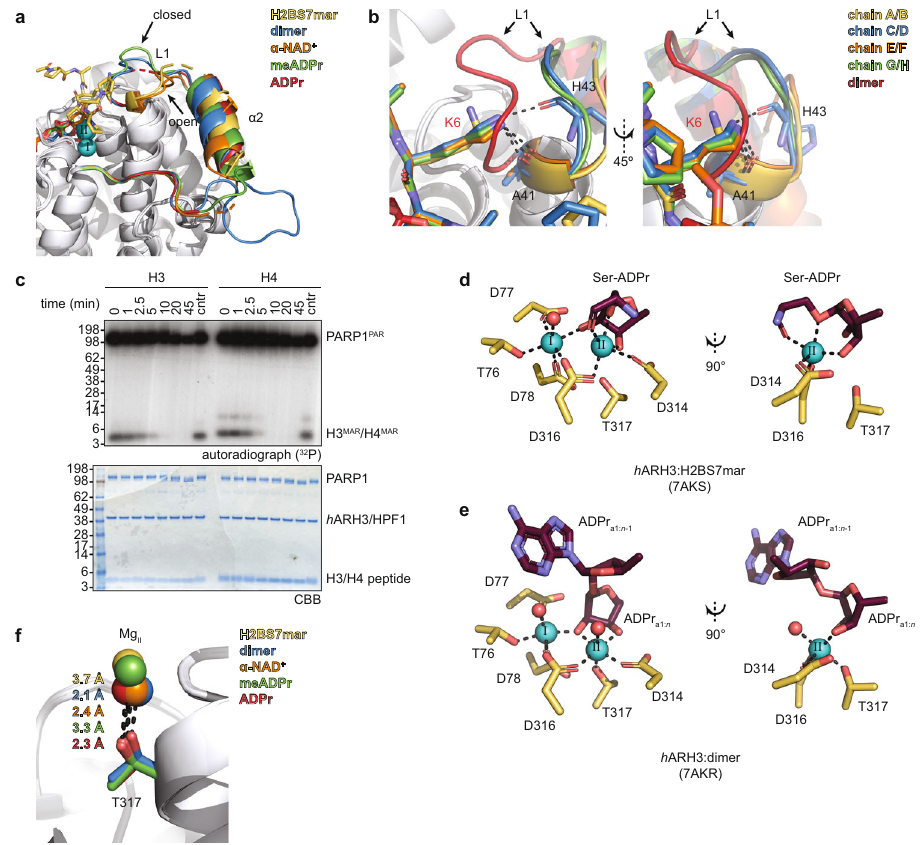
Fig. 6 Distinct modes of substrate coordination by ARH3. a Ligand-induced conformational changes in the Glu41- fl ap. Both H2BS7mar and α -NAD + induce an open conformation characterised by the displacement of loop L1 and helix α 2. In contrast, the Glu41- fl ap of the structures containing ADPr, PAR dimer and meADPr crystallised in a close conformation, thus allowing interaction of Glu41 with Mg II (see also Supplementary Fig. 12). Ligand and Glu41- fl ap are given in corresponding colours and Mg 2 + ions as turquoise spheres. Representation of the h ARH3:ADPr complex is based on PDB 6D36. b Peptide Lys6 can interact with the displaced loop L1 via polar backbone interaction (dashed lines) with Ala41 (Glu41 in wt h ARH3) and His43. For comparison closed Glu41- fl ap conformation of the h ARH3:dimer complex is given (red). c Presence of a KS motif is dispensable for ARH3 activity. Histone H3 and H4 peptides were enzymatically Ser-MARylated by PARP1/HPF1 in presence of 32 P-NAD + . Modi fi cation reversal by hARH3 was monitored as time-course experiment and representative results of two independent experiments are shown. d , e In fl uence of ligand binding on the coordination of the catalytic magnesium ions. Liquorice representation of ligand (purple) placement and magnesium (turquoise) coordination within the active site. Note, contacts and atoms involved in Mg I coordination are omitted for clarity in the right panels. Water molecules are given as red spheres and coordination bonds are black dashed lines. d H2BS7mar provides three ligand atoms (3 ″ O, 1 ″ O [scissile bond] and S7 backbone-carbonyl oxygen) to the coordination of Mg II , which leads to displacement of all water molecules from the Mg 2 + ion as well as loss of the Thr317-Mg II coordination (see ( f )), thus adopting a strained square- pyramidal coordination. e Coordination of the PAR dimer is relaxed and both magnesium ions adopt an octahedral coordination. The scissile bond does not engage in the coordination and both Mg 2 + ions coordinate an axial water molecule. f Comparison of ligand-dependent distances between Thr317 and Mg II . The distance within the h ARH3:ADPr complex is based on PDB 6D36. Source data are provided as a Source data fi